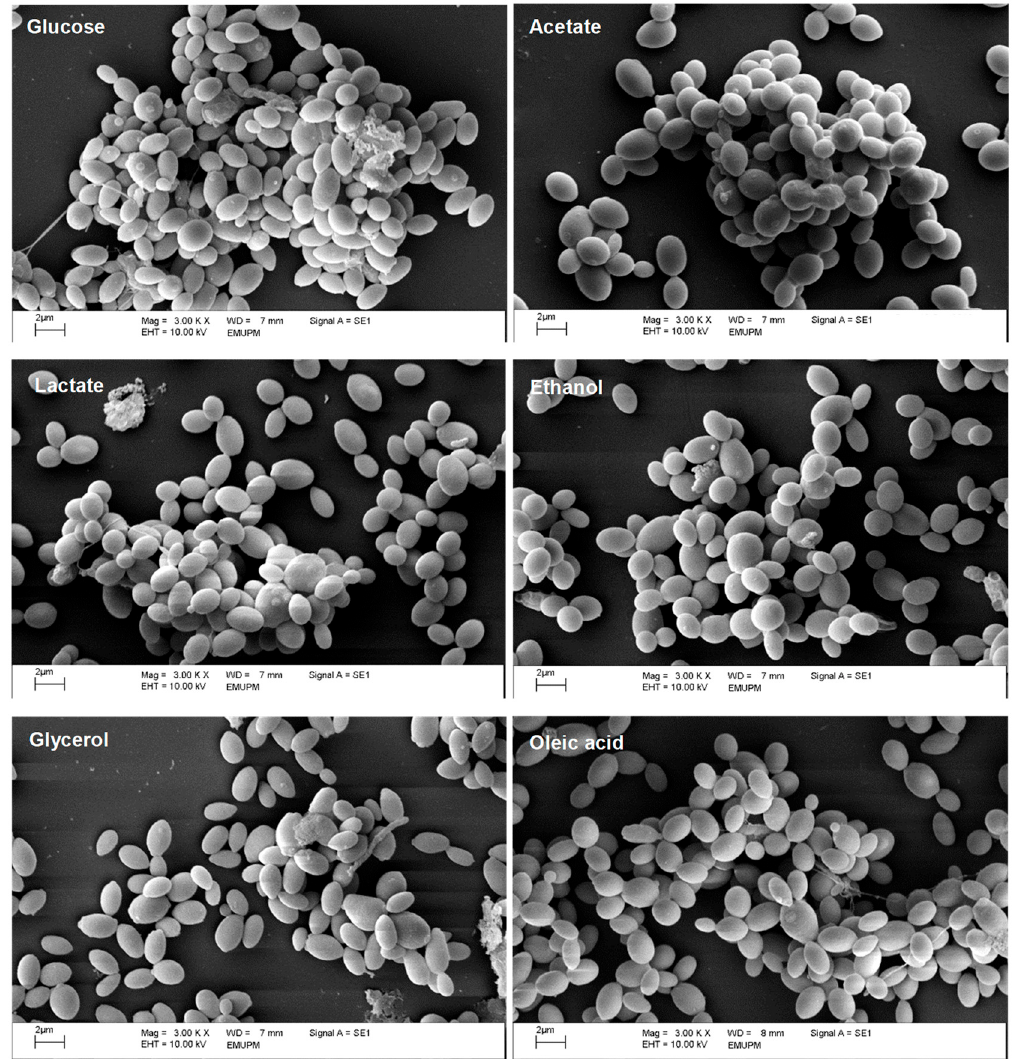
Figure 2. Effect of glucose and alternative carbon sources on the biofilm structures of C. glabrat. Representative scanning electron photomicrographs from 48 h biofilms of C. glabrata grown on glucose and alternative carbon sources, viewed under scanning electron microscopy (SEM) at a magnification of 3000×. Scale bar represents 2 µm.